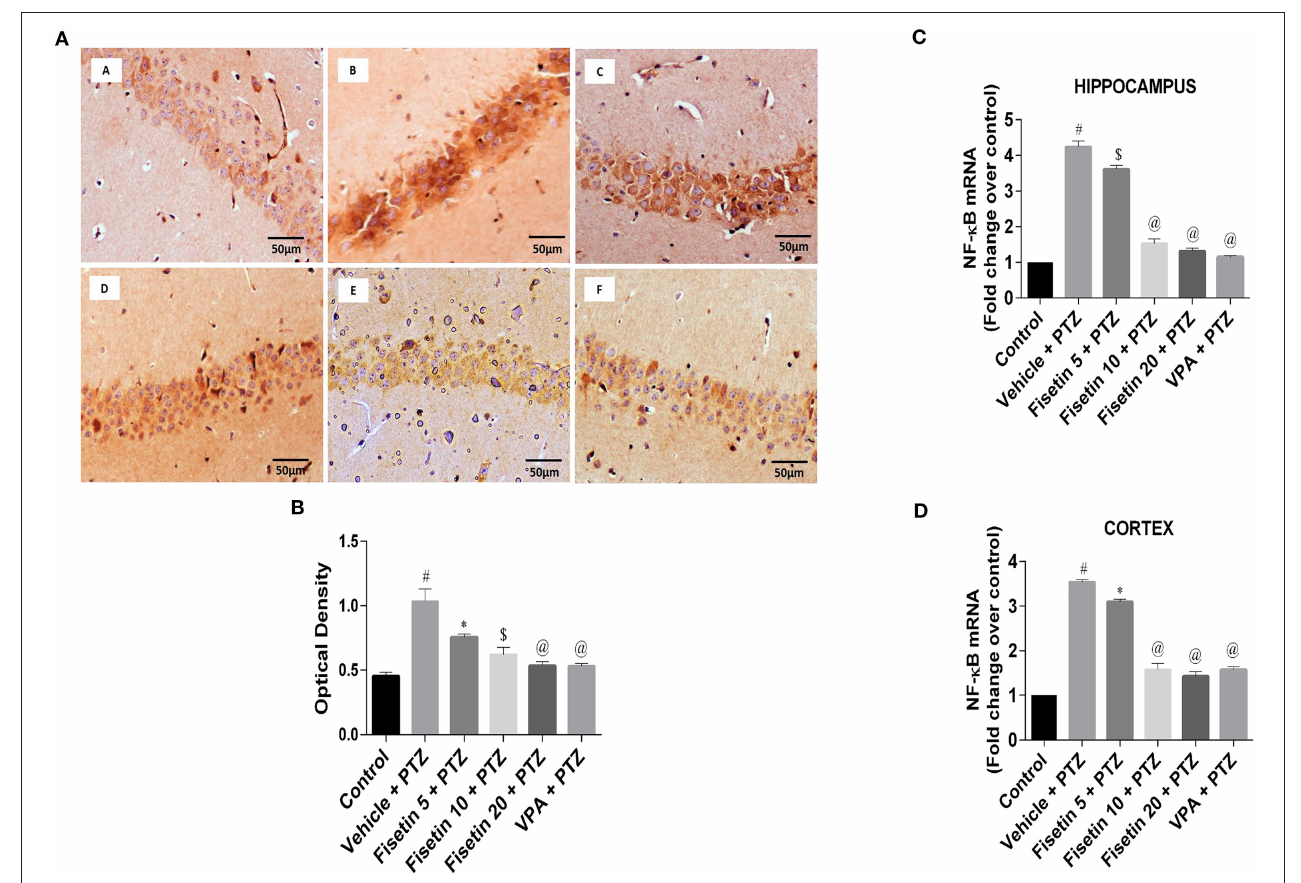
FIGURE 5 | Effect of Fisetin Administration on NF- κ B in the Hippocampus and Cortex of Experimental Mice. (A) Photomicrographs of the hippocampus in different experimental groups are shown (40X). (A) Control, (B) vehicle + PTZ, (C) fisetin 5 + PTZ, (D) fisetin 10 + PTZ, (E) fisetin 20 + PTZ, and (F) VPA + PTZ. Fisetin treatment resulted in reduced immunoreactivity of NF- κ B protein in hippocampal neurons compared with the vehicle + PTZ group. (B) Quantitative estimation of NF- κ B immunostaining ( n = 3). (C) mRNA expression of NF- κ B in the hippocampus ( n = 5). (D) mRNA expression of NF- κ B in the cortex ( n = 5). Data were analyzed by one-way ANOVA followed by Tukey’s multiple comparison test and expressed as mean ± SEM. # p < 0.001 as compared with control group; * p < 0.05 as compared with vehicle + PTZ group; $ p < 0.01 as compared to vehicle + PTZ group, and @ p < 0.001 as compared with vehicle + PTZ